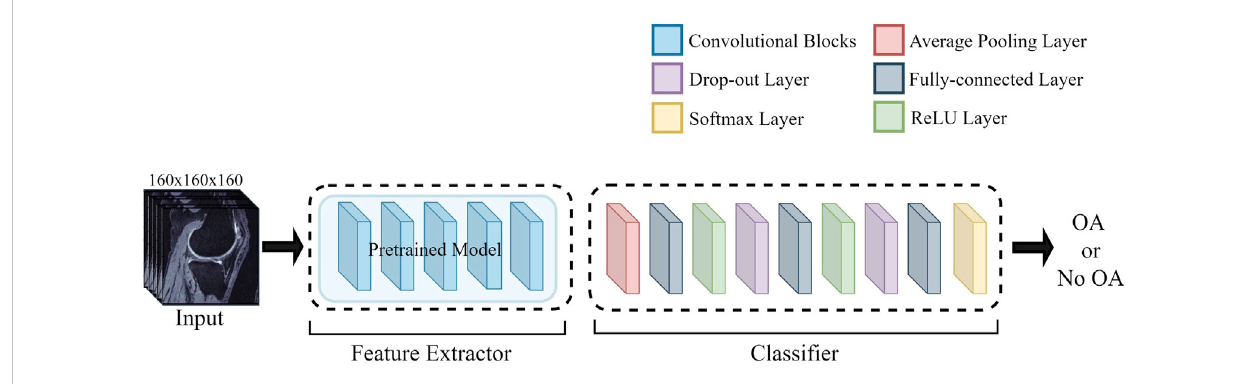
FIGURE 1 General neural network architecture used in this study.